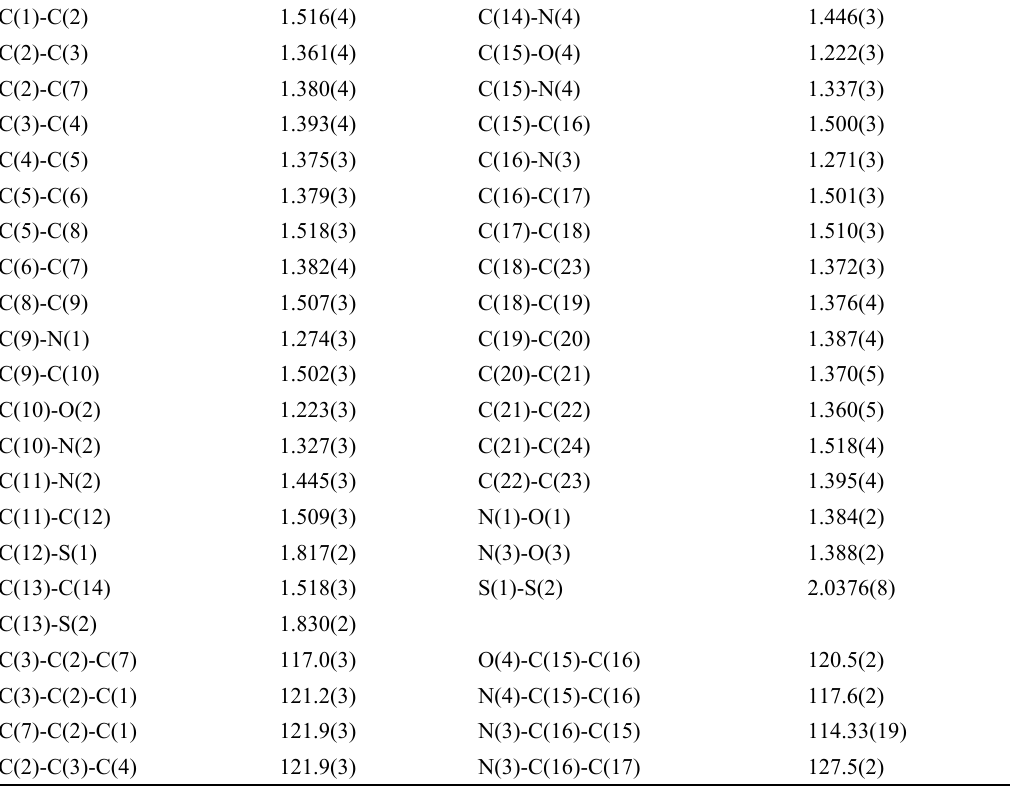
Table 3. Selected bond lengths (Å) and angles (°) for compound 8b